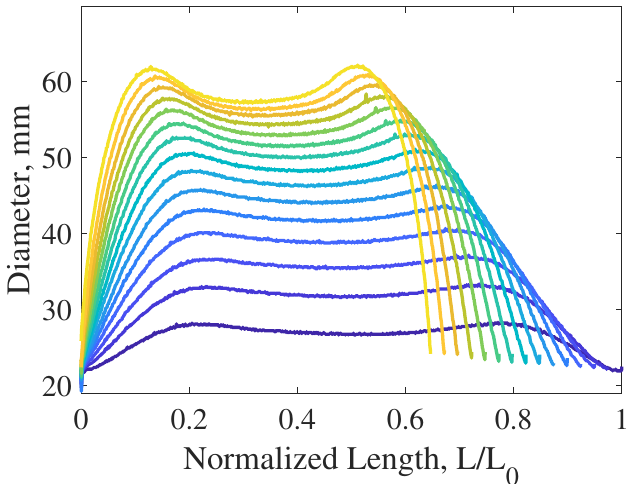
Figure 13. Evolution of the PAM’s shape profile for its full contraction range at 689kPa